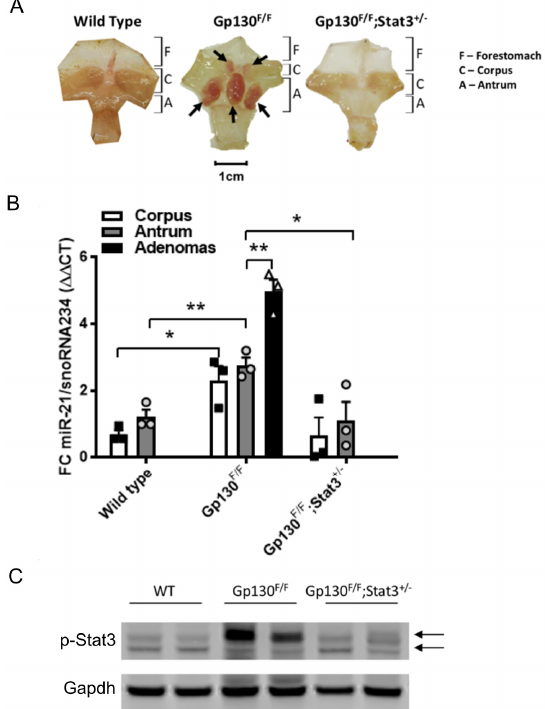
Figure 1. miR-21 expression in gastric tissues correlates with excessive Stat3 activity. ( A ) Whole- mount images of stomachs, excised from 8-week old mice of the indicated genotype and opened along the outer curvature. The arrows indicate adenomas in the glandular stomach. ( B ) qRT-PCR TaqMan analysis of the miR-21-5p expression in the unaffected corpus and antrum, as well as in gastric adenomas of 8-week old mice with the indicated genotypes. The individual circular, triangular and square data points represent the average values of technical triplicates normalized against the expression of snoRNA234. ( C ) p-Stat3 immunoblot analysis of excised stomach tissue. Gapdh was used as a loading control. Each lane corresponds to an individual mouse, with the arrows indicating the Stat3 α and Stat3 β isoforms. Each symbol represents an individual mouse, and the data are depicted as the mean ± SEM. n = 3 mice per group. * p < 0.05; ** p <